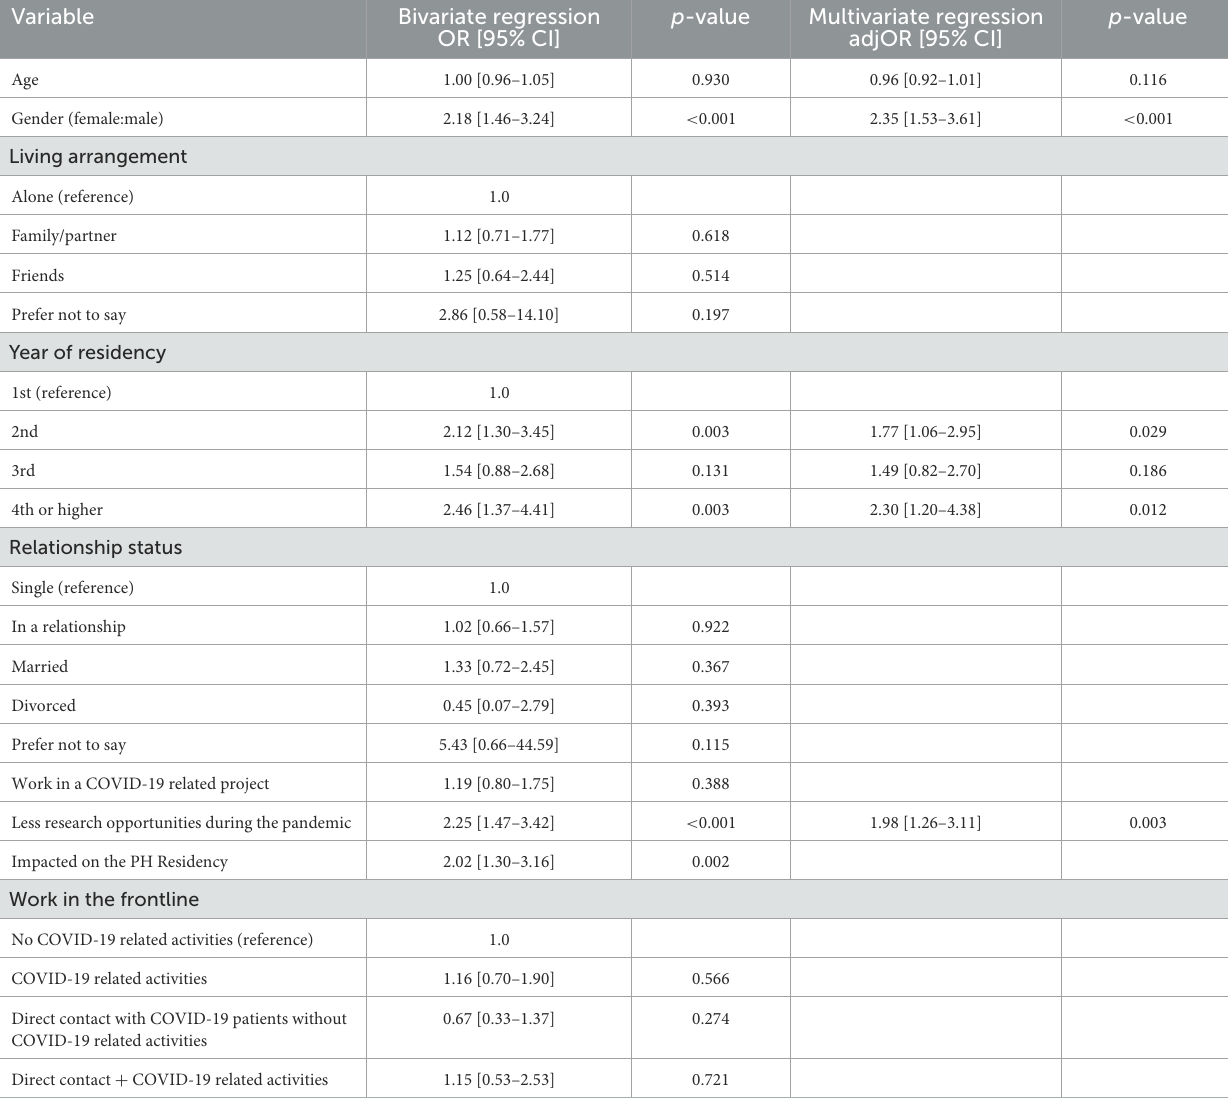
TABLE 3 Factors associated with stress, resulting from the bivariate and multivariate regression analysis of the data (Public Health Residents’ Mental Health, Europe,